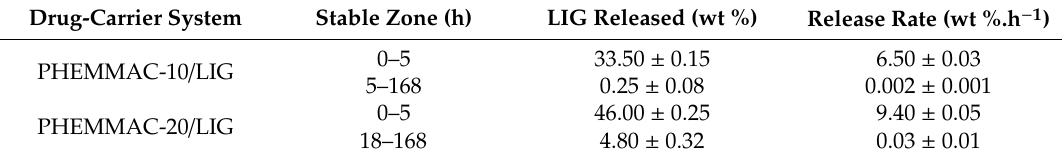
Table 8. Stable zones and instantaneous release of lignocaine from the PHEMMAC / LIG drug-carrier systems with di ff erent MMA / HEMA